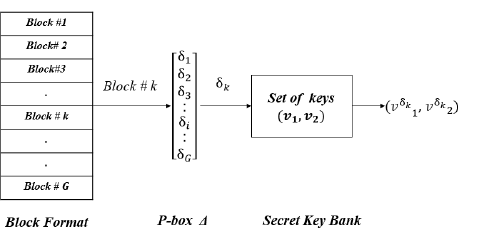
Figure 4: DK Selection Algorithm